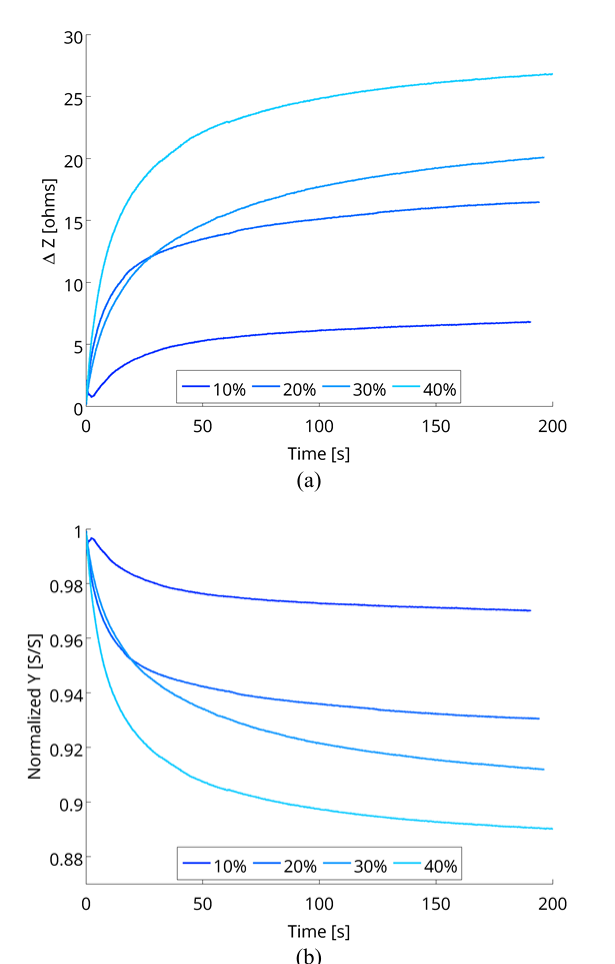
Fig. 8. The (a) average change in impedance over time and the (b) admittance normalized to the maximum value over time seen for each level of compression. Twelve individual runs comprise each of the curves. Time was set to zero at the point compression